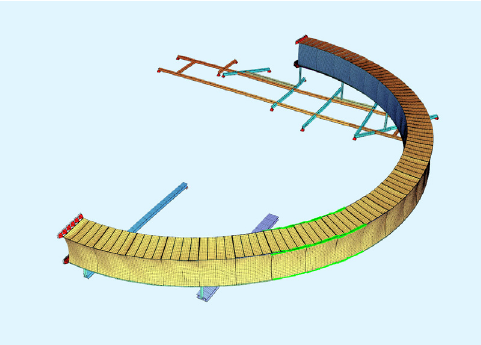
Figure 12: Shell element model of one half of the walkway under live loads, wind loads and snow loads (scaled up